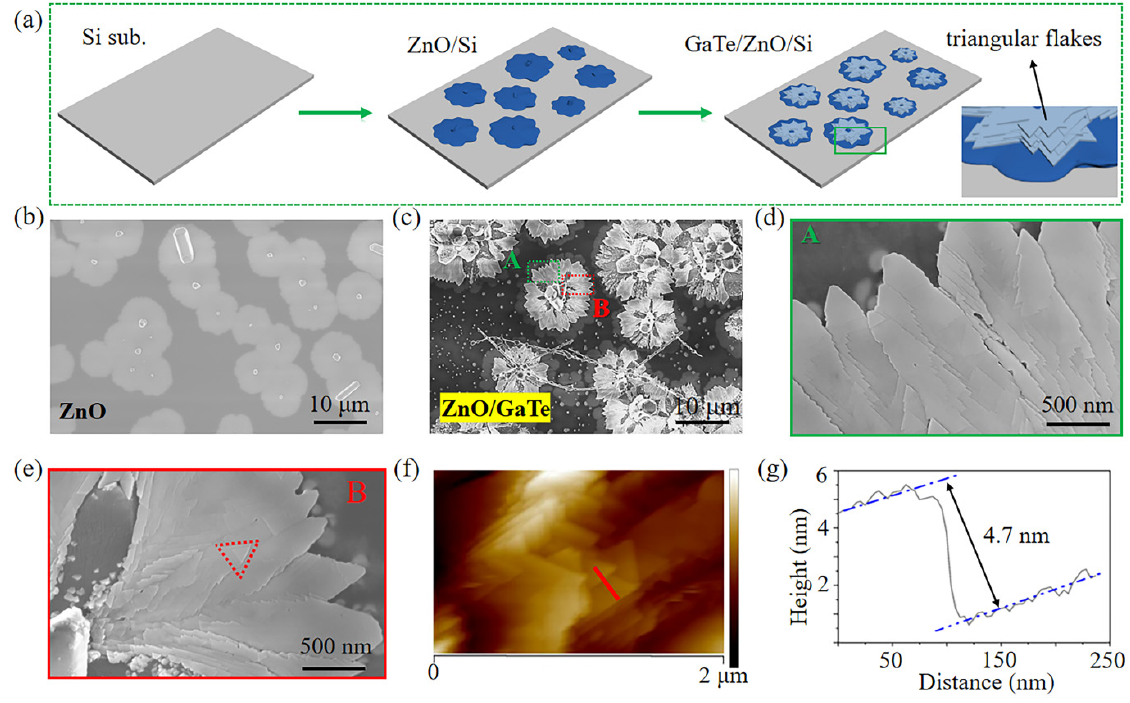
Figure 1. ( a ) Fabrication process of GaTe nanosheet flower by a two-step CVD process. ( b ) SEM image of ZnO islands obtained using the CVD method. ( c ) SEM image of GaTe nanosheet flower. ( d , e ) High-magnification SEM images of the regions marked by a green (A) and a red (B) rectangle in ( c ), showing that the petals are formed from GaTe triangular flakes. ( f ) AFM image of the petals of GaTe nanosheet flower. ( g ) Height profile along the line marked in ( f ), revealing that the thickness of GaTe triangles is ~4.7 nm.